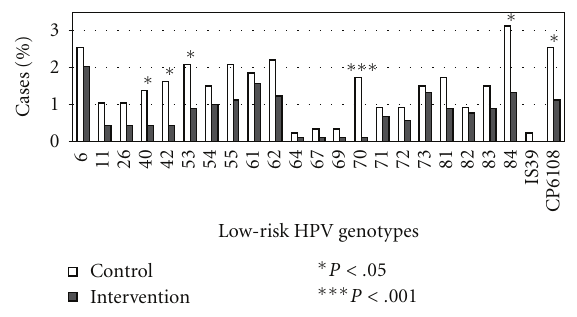
Figure 1: Distribution of the low-risk HPV genotypes as a function of randomization group among the 1753 participants (intention to treat population).